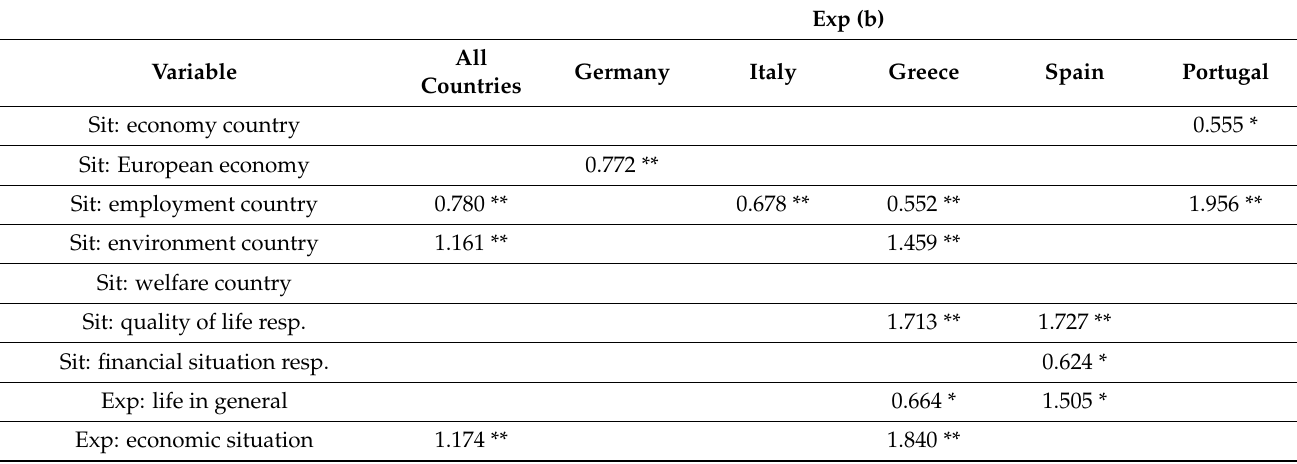
Table 5. Impact of economic factors on national attachment: Germany, Spain, Italy, Greece, and Portugal (2006). VD: 0, not very attached; 1, very attached. Source is authors’ own elaboration based on EB 65.2. p values: * ≤ 0.05, ** ≤ 0.01, *** ≤